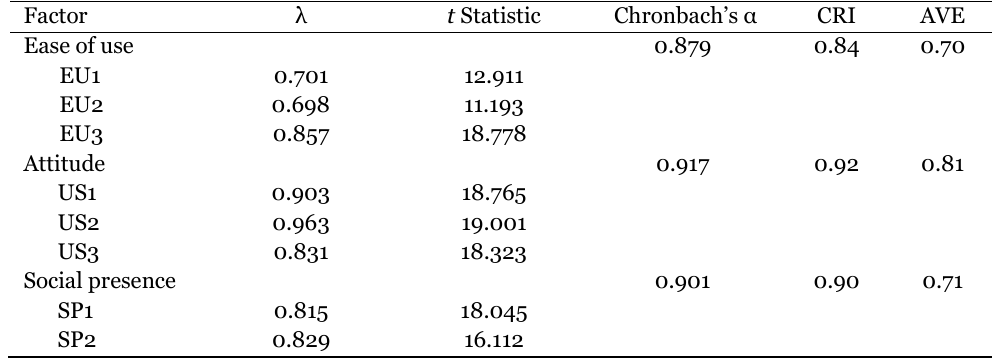
Standardized Estimations for Observable